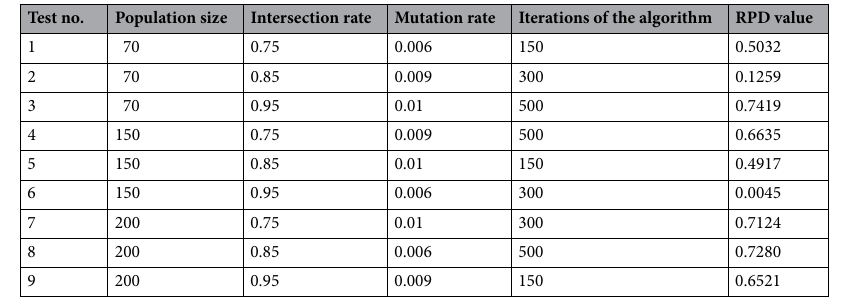
Table 4. Orthogonal table for setting parameters of NSGA-II algorithm.